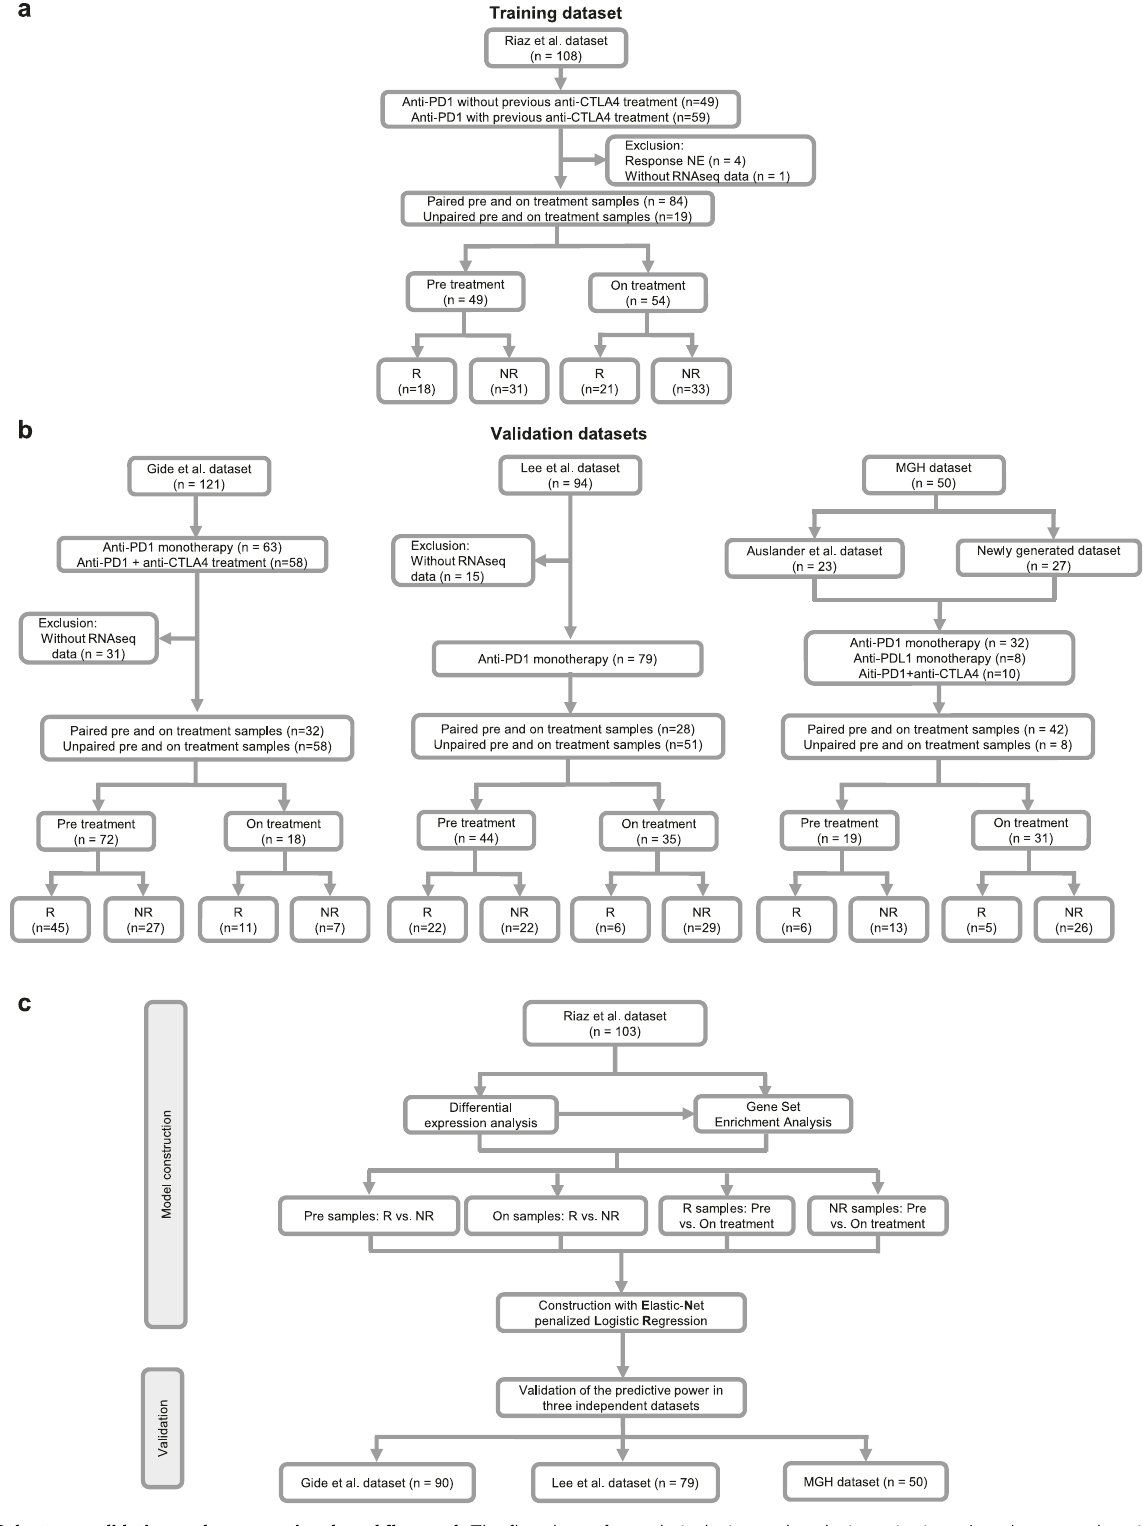
Fig. 1 Cohort consolidation and computational work fl ow. a, b The fl owchart of sample inclusion and exclusion criteria. a A melanoma cohort including patients who were treated with anti-PD-1 therapy was selected as training dataset including 49 pre-treatment and 54 on-treatment samples. b Three independent melanoma cohorts and one newly generated cohort were enrolled as validation datasets in this study. A total of 135 pre-treatment and 84 on- treatment samples were included for the fi nal analysis. c The computational work fl ow of model construction and validation. Predictive models were constructed using pre-treatment and on-treatment samples, respectively, from the Riaz et al. dataset. Models were validated in three independent datasets. NE not evaluation, R responders, and NR